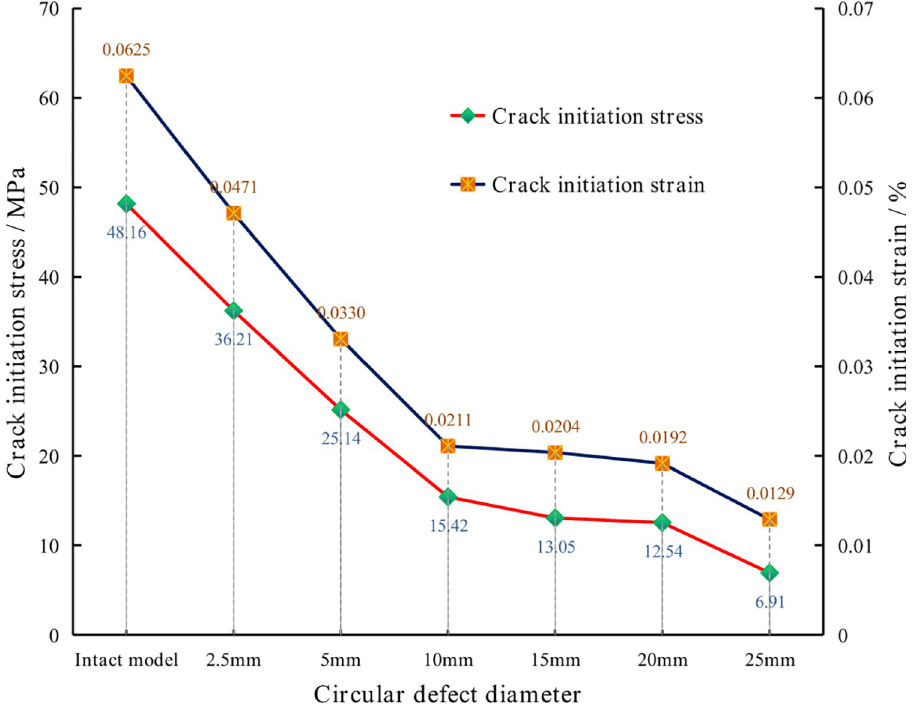
Fig 8. Crack initiation stress and crack initiation strain in each